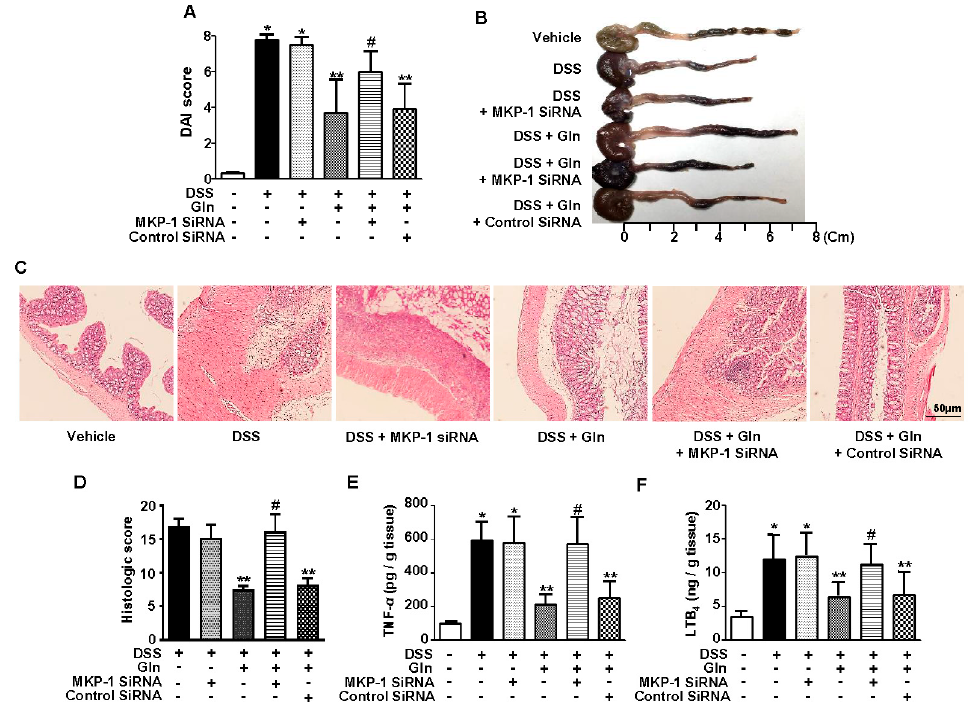
Figure 3. Gln ameliorates colitis via MKP-1 induction. ( A ) Disease severity; ( B ) the colon length on day 5; ( C ) histological examination on day 5; ( D ) histological score; ( E , F ) colonic levels of TNF- α and LTB 4 ; Data in ( A , E , F ) represent the means ± SEM of three independent experiments ( n = 5 mice/group/time point); ( B , C ) A representative from three independent experiments ( n = 3 mice/group/time point) is shown. Scale bar = 50 μ m. * p < 0.001 vs. vehicle group; ** p < 0.05 vs. DSS group; # p < 0.05 vs. DSS + Gln group in ( A , D – F ).